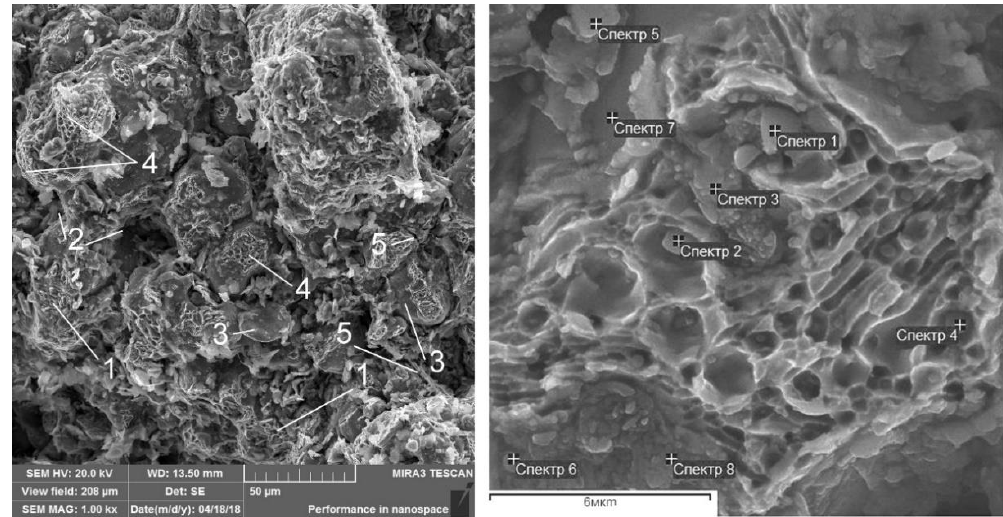
Figure 11. Fractographies of FeGr1 with the mixture of C, Al 2 O 3 , and SiC particulates: 1—areas of quasi-brittle fracture; 2—pores; 3—areas of inter-granular fracture; 4—areas of dimple viscous destruction; 5—microcracks. Table 4. Results of the SEM analysis of the fractural submicroarea of the FeGr1+ mixture of C + Al 2 O 3 + SiC. Number of Spectrum C, % O, % Al,